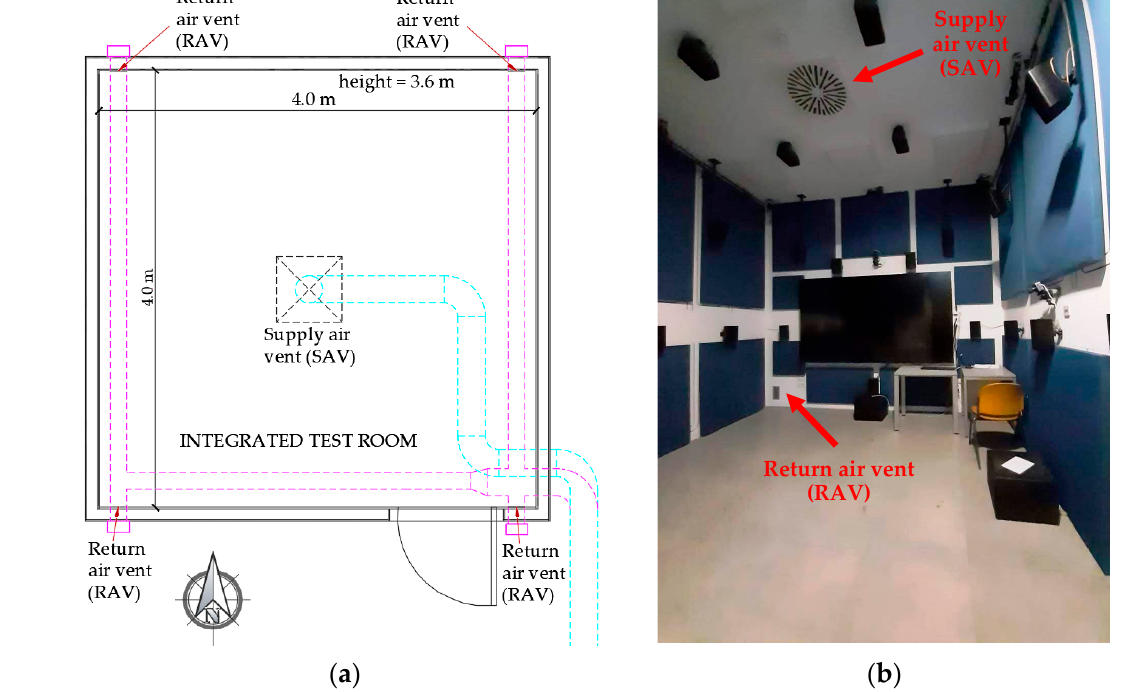
Figure 2. ( a ) Floor plan, and ( b ) internal view of the integrated test room. Table 2 indicates the characteristics of the envelope of the integrated test room in Table 2. Integrated test room envelope’s